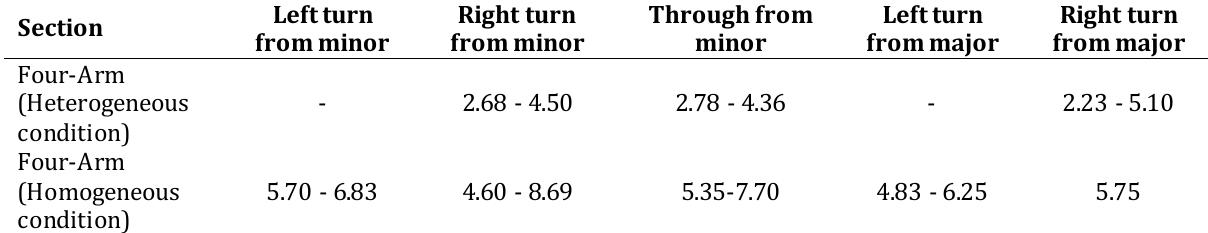
Table 8: Comparative critical gap (in seconds) range for turning movement for developed and developing countries Section